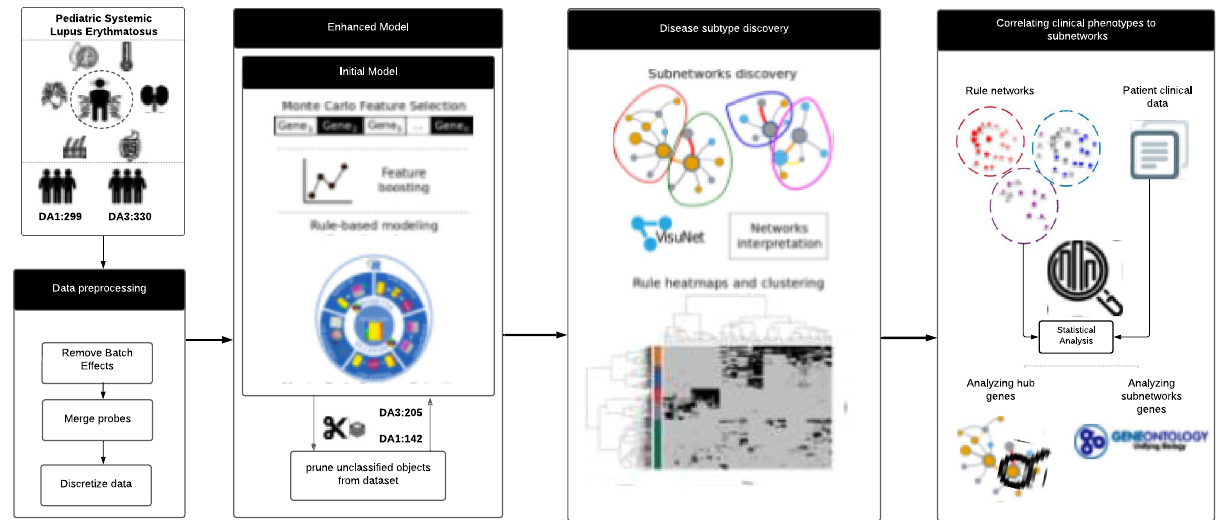
Figure 1. Overview of the modelling process implemented to classify and interrogate gene expression relationships between DA1 and